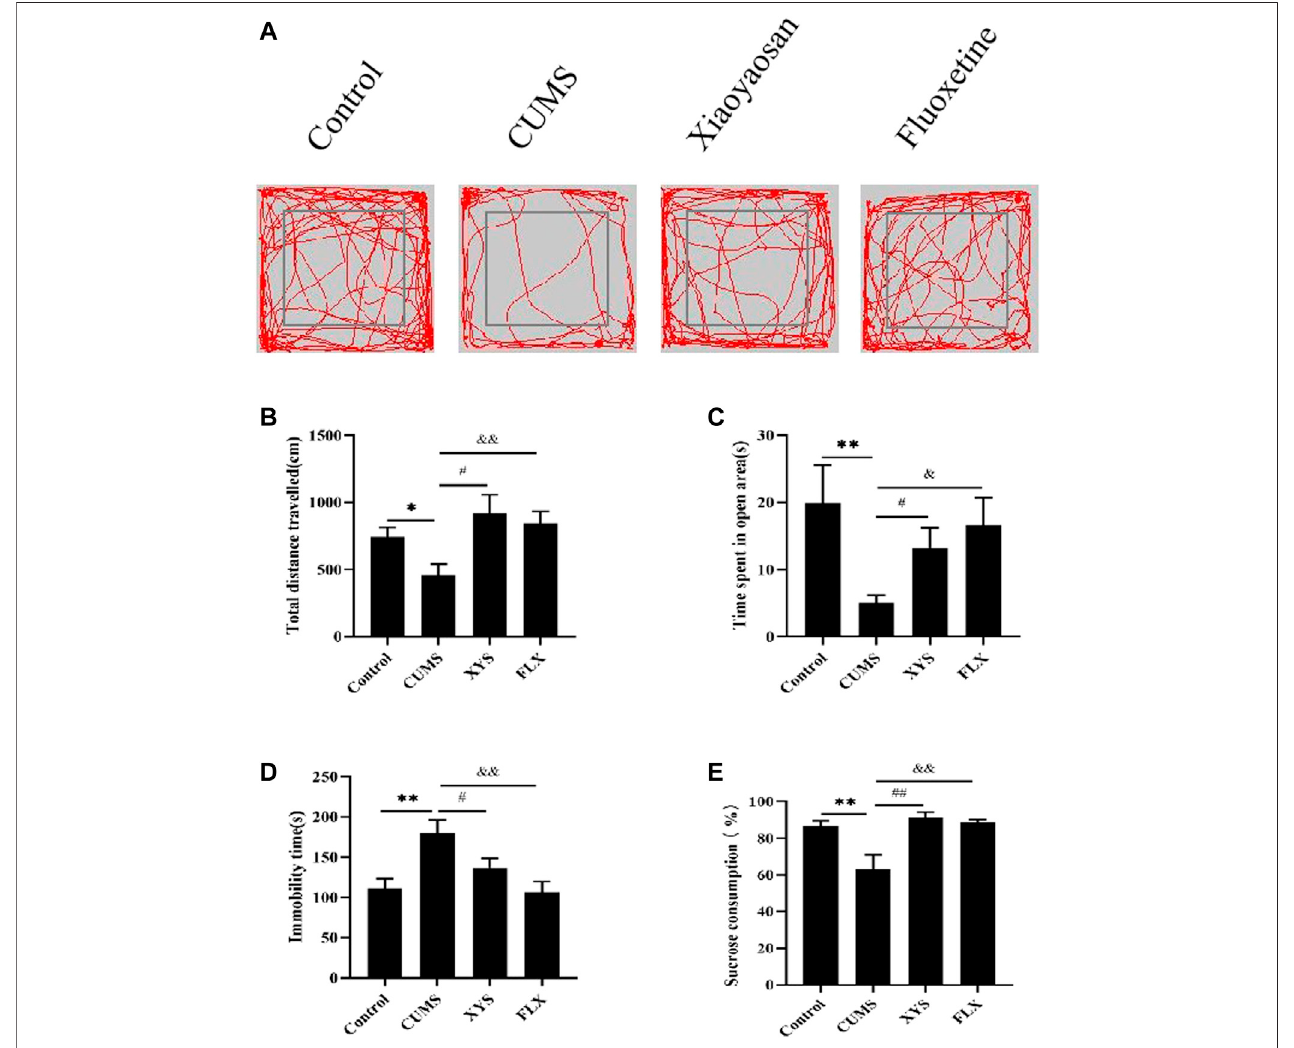
FIGURE3| Xiaoyaosanamelioratedepression-likebehaviorsinmiceinducedbyCUMS. (A) MapofthetrajectorytakenbymiceineachgroupintheOFTassessed byvideotrackingsoftware. (B) TotaldistancetraveledintheOFT(F(3,44)=4.017, p =0.0130,n=12). (C) TimespentintheopenareaintheOFT(F(3,44)=2.723, p = 0.0556, n = 12). (D) Immobility time spent in the TST (F (3, 44) = 6.056, p = 0.0015, n = 12). (E) Sucrose consumption in the SPT (F (3, 44) = 8.602, p = 0.0001, n = 12). The values shown represent the mean ± SEM. The values represent the mean ± SEM. p p < 0.05 or pp p < 0.01 compared with the control group. # p < 0.05, ## p < 0.01 compared with the CUMS group. & p < 0.05, & p < 0.01 compared with the CUMS